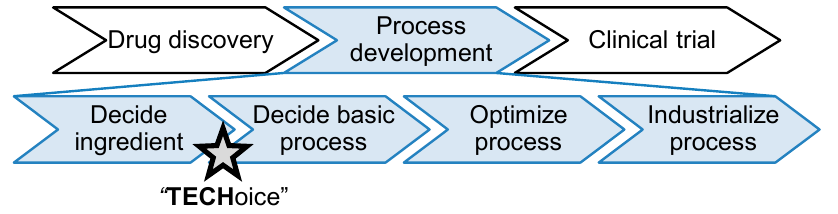
Figure 2. Intended use phase of the tool “ TECH oice”.